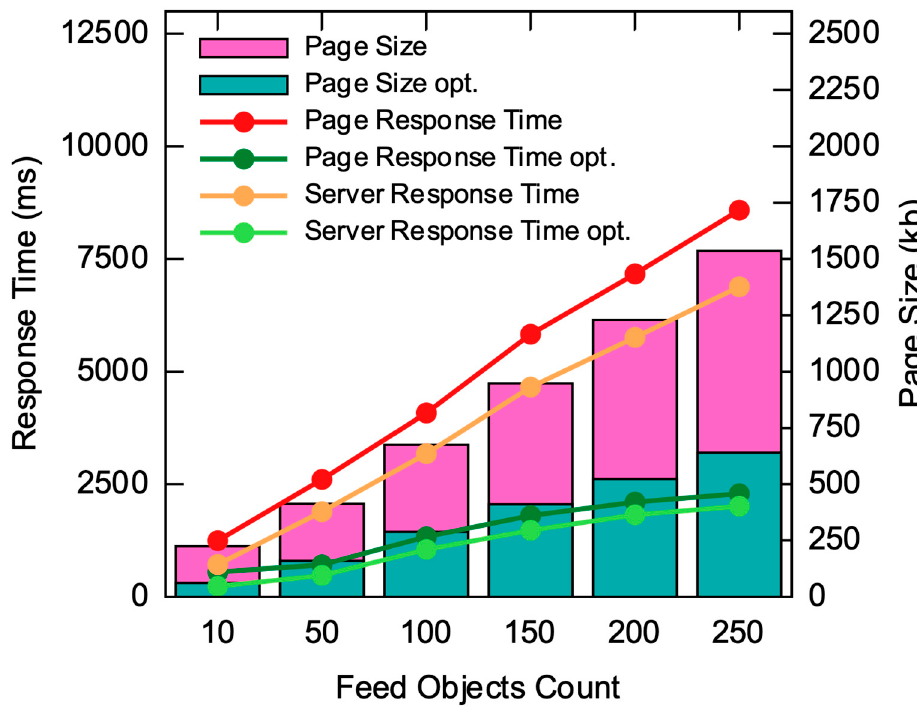
Figure 8. Relationship between the number of objects retrieved, the response time (lines) and the page size (bars) for optimized and baseline applications.